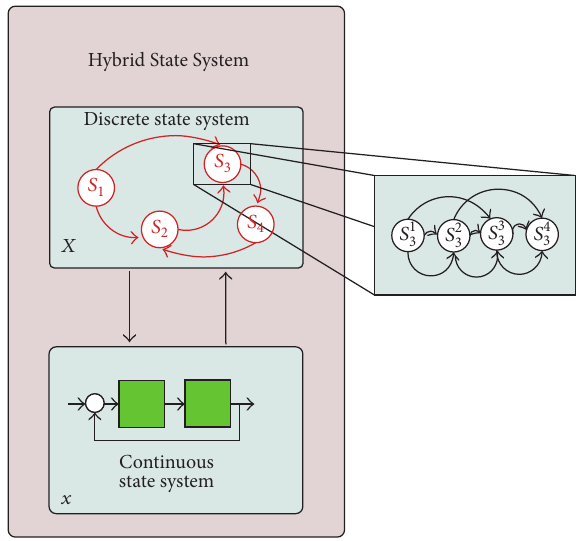
Figure 2: Overall HSS+HMM model. The left side of the figure describes the overall architecture of DSS and CSS. The right side indicates how each metastate of the DSS is modeled as an HMM.